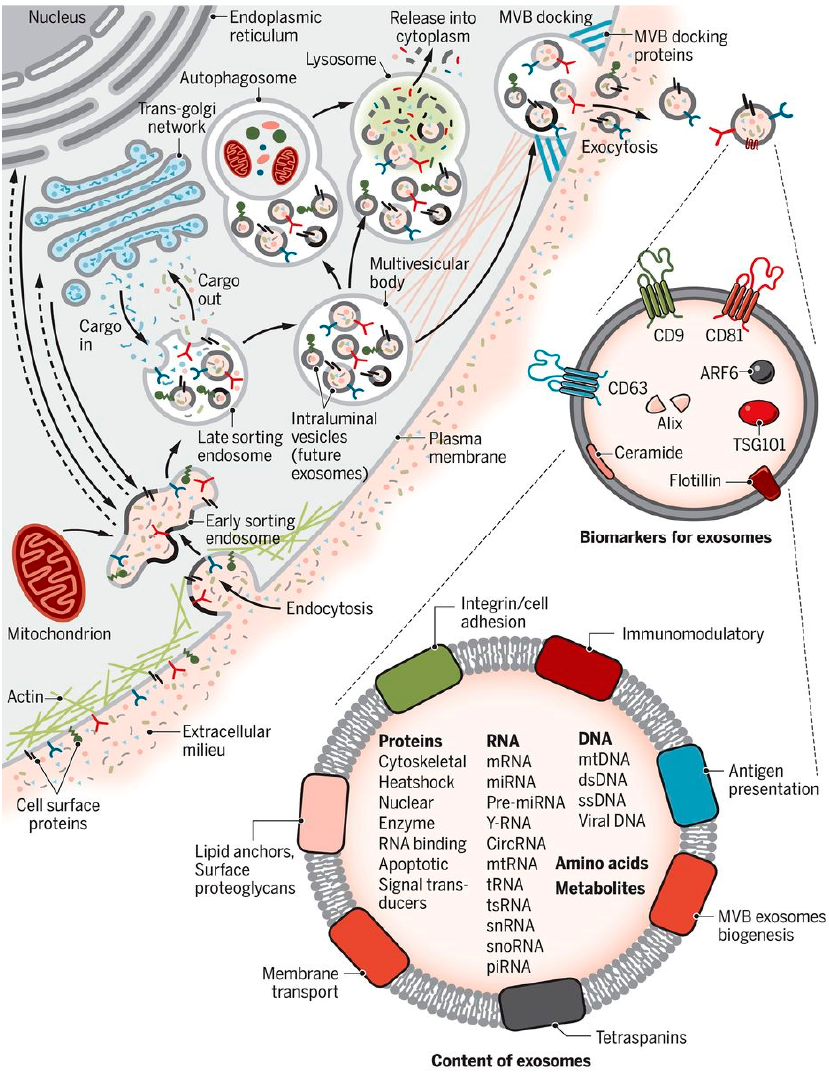
Figure 1 . Biogenesis and loading pattern of exosomes. The key steps of exosome biogenesis include the endocytosis of metabolite endocytosis into the cell, formation of exosomes in the lumen of plasma membrane, and exocytosis of the loaded exosomes. Figure is taken from [35], copyright from the American Association of Advancement of Sciences.